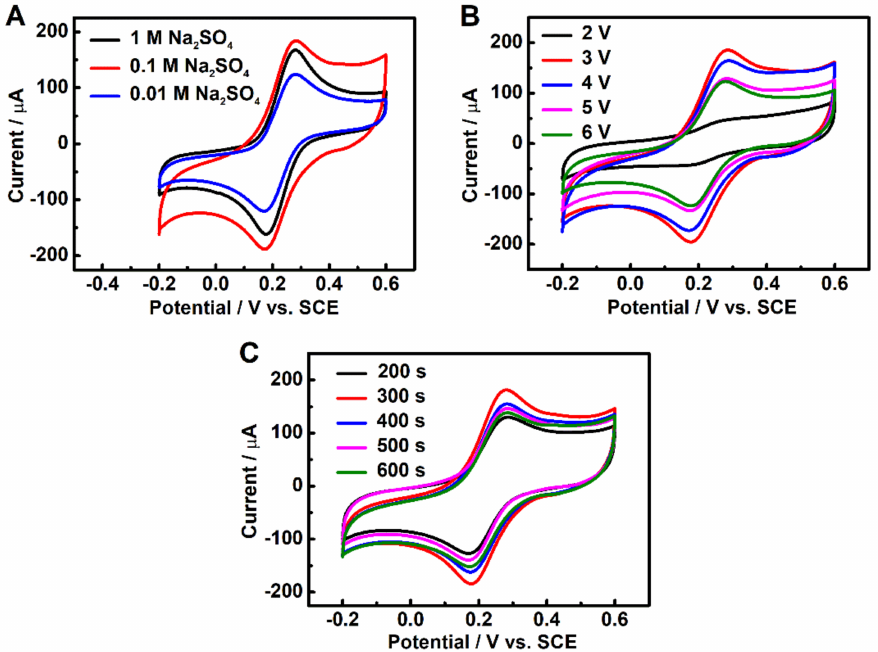
Figure 1. CV curves of 3DGrls/PGE prepared with different ( A ) electrolyte concentrations, ( B ) elec- trolysis potentials and ( C ) electrolysis times in a 5-mM [Fe(CN) 6 ] 3 − /4 − solution at a scan rate of 50 mV s − 1